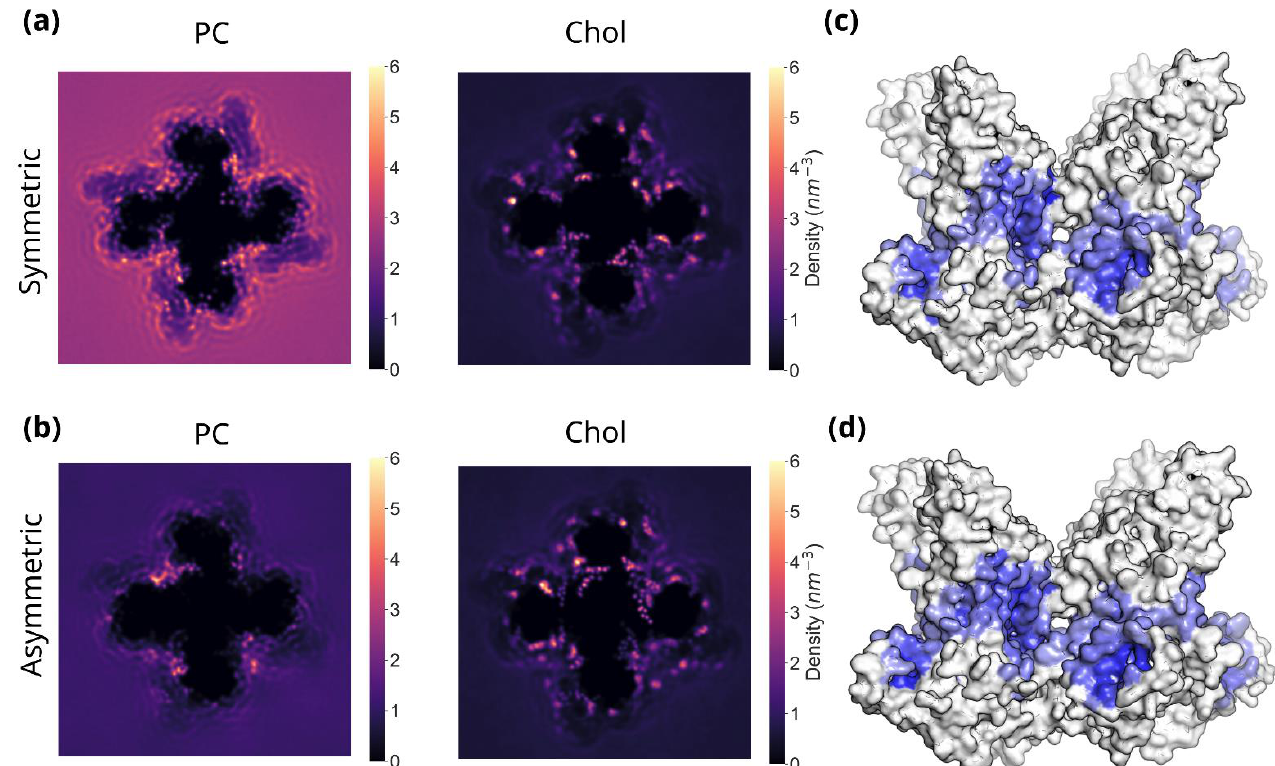
Figure 2. ( a ) Two-dimensional density maps showing PC and cholesterol densities for the two- component, symmetric membrane. For each system, the maps are averaged over four repeats and a Gaussian filter with a sigma value of 3 has been applied. ( b ) As in ( a ), for the six-component, asymmetric membrane. ( c ) Cholesterol enrichment map for the symmetric membrane, indicating in blue the residues where cholesterol binding is enriched (i.e., cholesterol accounts for over 30% of the contacts). Residues in grey indicate residues where cholesterol binding is not enriched. ( d ) As in ( c ), for the six-component, asymmetric membrane.